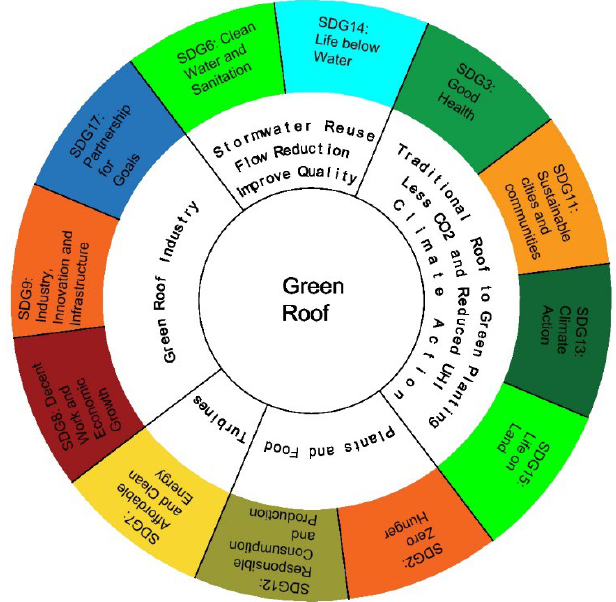
Figure 5. Sustainable Development Goals and Green Roof .